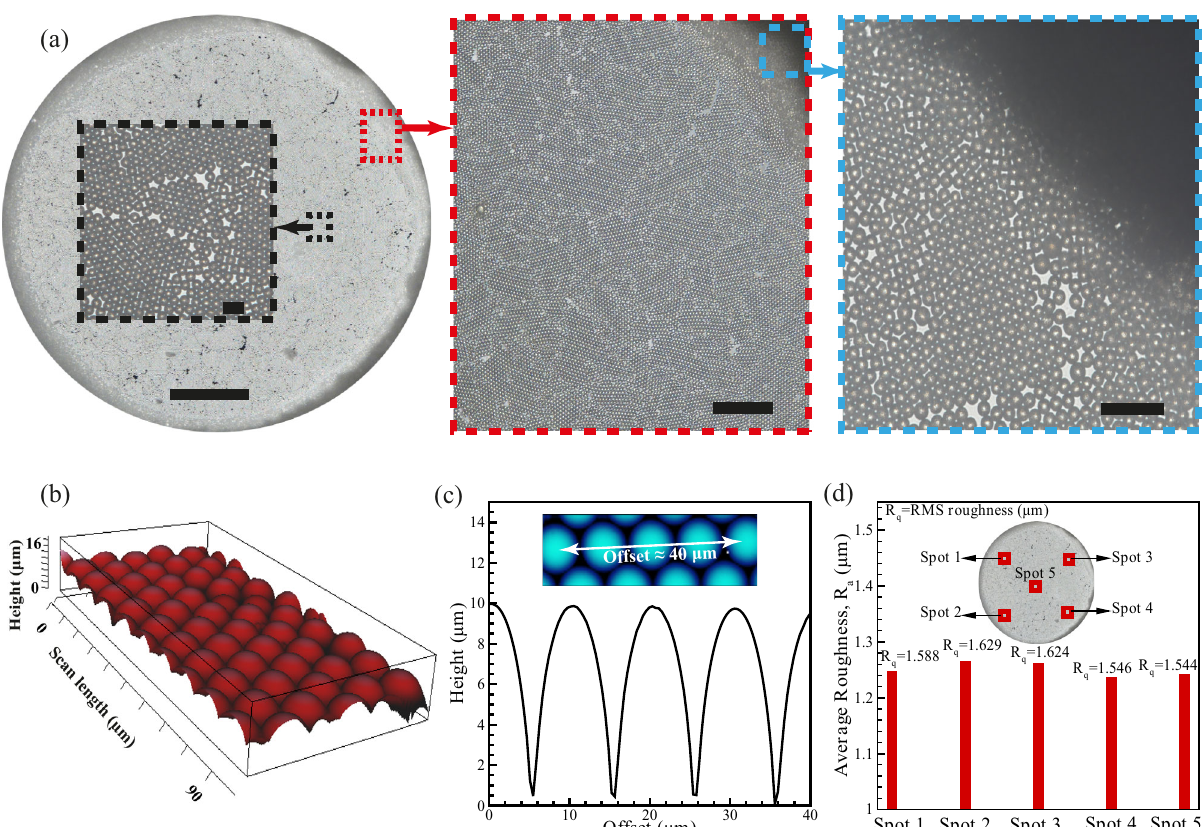
Fig. 3 Monolayer deposition of the polystyrene microparticles using the proposed method. a Bright fi eld microscopy image of the deposited microparticles, representing monolayer formation along the surface and at the contact line; scale bars: left (main: 500 μ m, inset: 20 μ m), middle: 200 μ m, right: 50 μ m. b Three-dimensional (3D) view of the deposited microparticles using atomic force microscopy (AFM) topography image, showing highly ordered microparticles. c The measured height of the deposited layer for fi ve microparticles placed next to each other, analyzing the AFM image (offset is the length of the sketched line). d The average roughness ( R a = 1.25 ± 0.012, 95% con fi dence interval) and root mean square (RMS) roughness ( R q = 1.59 ± 0.04, 95% con fi dence interval) were measured at different spots of the deposited layer, con fi rming the uniform distribution of microparticles. Source data are provided as a Source Data fi